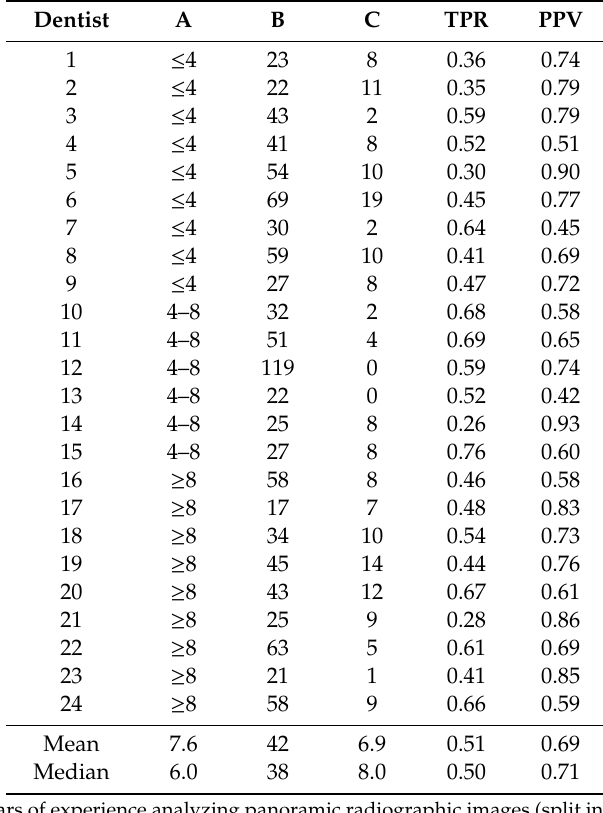
Table 2. Performance metrics for each OMF surgeon, based on their assessment of 102 radiographic images (2248 images read in total) and survey response.